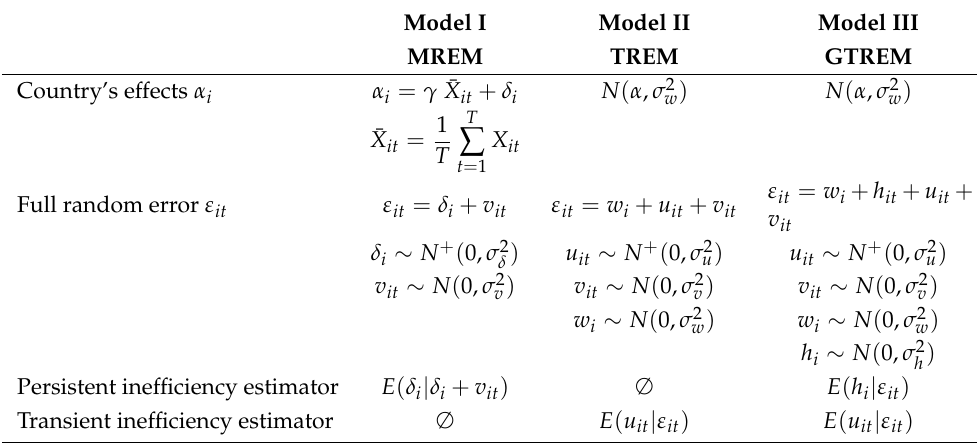
Table 4. Econometric specification of stochastic energy demand frontier: country specific effects, error term, and